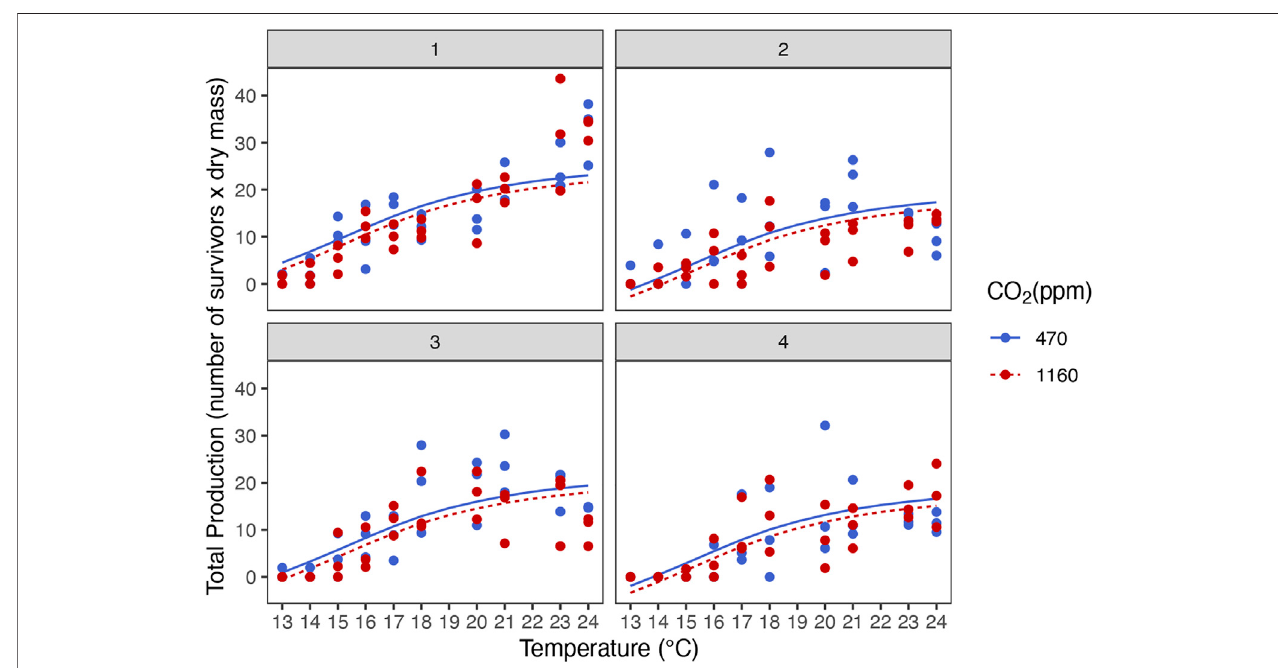
FIGURE 3 | Additive effect of temperature and ocean acidi fi cation on total production of stage III Homarus gammarus larvae for the four hatches analyzed. Panels 1 – 4 respectively.